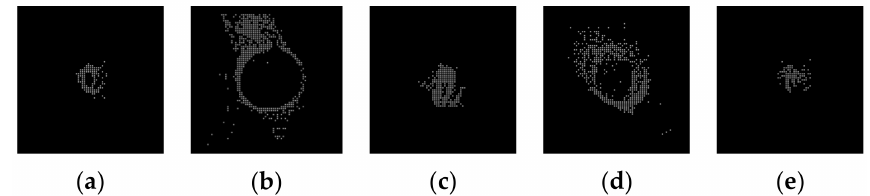
Figure 5. Binary images of five slices of plot 1 and 2 in multi-scan mode with height of 1.25–1.35 m, gray scale threshold of 1. ( a ) Tree 2; ( b ) Tree 3; ( c ) Tree 7; ( d ) Tree 11; ( e ) Tree 21.